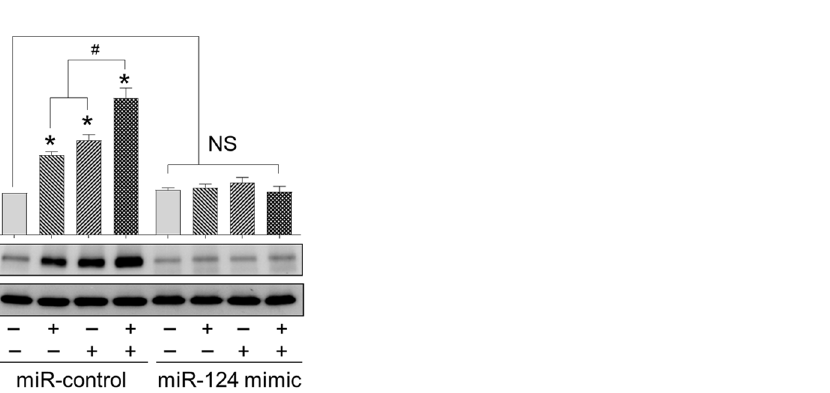
Figure 5. HIV-1 Tat and/or cocaine significantly increased microglial activation. Representative western blotting analysis showing the expression of CD11b in HIV-1 Tat (25 ng/mL) and cocaine (10 µ M) exposed mouse primary microglial cells for 24 h. Data are mean ± SEM from six independent experiments. Nonparametric Kruskal–Wallis one-way ANOVA followed by Dunn’s post hoc test was used to determine the statistical significance of multiple groups. * p < 0.05 versus control; # p < 0.05 versus HIV-1 Tat or cocaine. NS: non-significant.